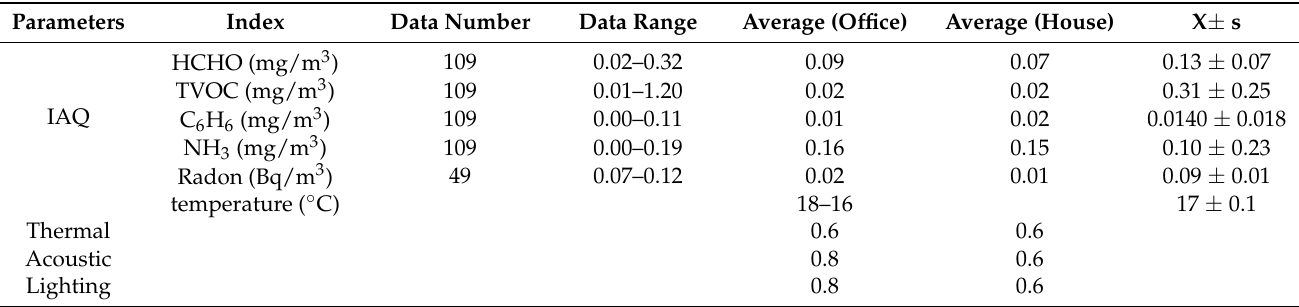
Table 4. Indoor environmental data